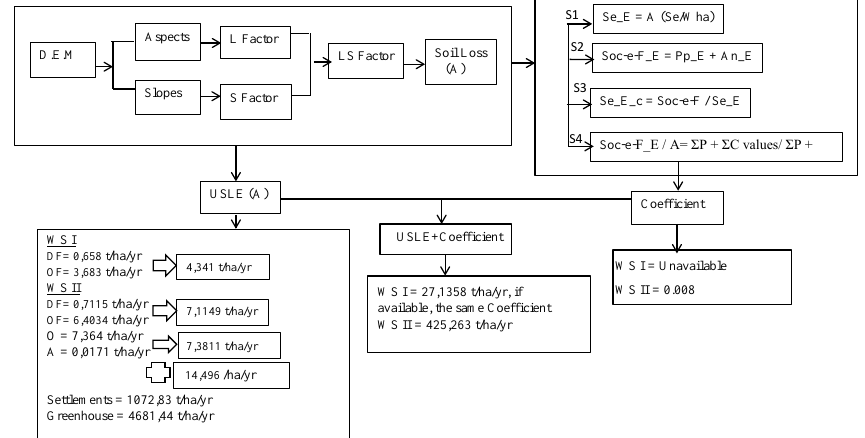
Figure 3. Steps calculating coefficient modified in the USLE that represents the contribution of socioeconomic factors to soil loss. The factors of the USLE estimated using GIS and working steps as mathematical processes to find a coefficient that contributed socioeconomic factors such as the number of people and animals ( A = tha − 1 yr − 1 ; Se – Settlements; Wha – size of WS II; Se E – effect of settlements on erosion; Pp – people population; Pp E – effect of people population on erosion; An – animal numbers; An E – effect of animal numbers